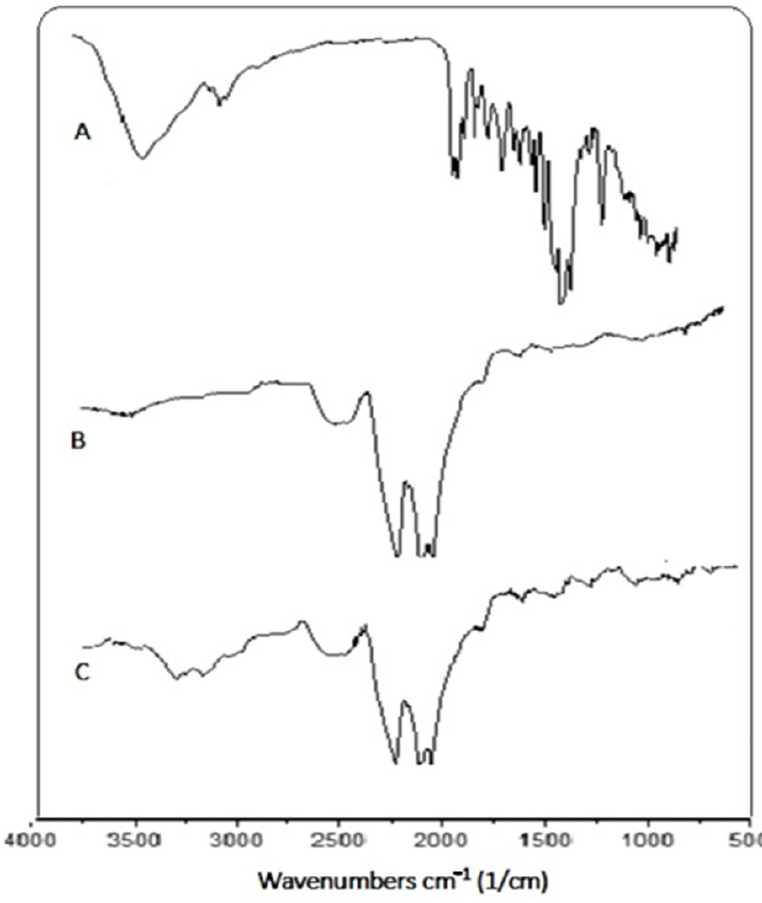
Figure 2. FTIR spectra: ( A ) LU/DIO mixture; ( B ) SeNPs; ( C ) GA/LU/DIO-SeNPs.